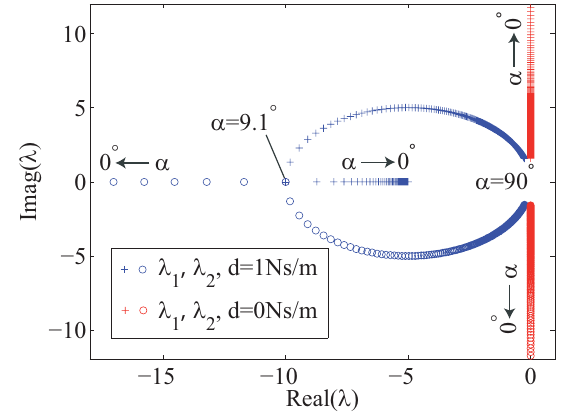
Table 1. Properties for mass on car system.